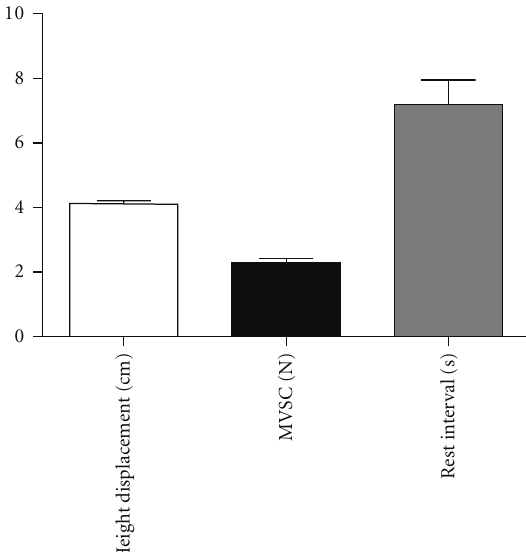
Figure 5: Height displacement (cm), maximal voluntary strength capacity (MVSC) during the concentric phase of muscle con- traction (N), and rest interval between repetitions (s) during the functional test. The height displacement in MVSC test was the same observed in the lifting phase. Data are expressed as mean ± SEM; N-